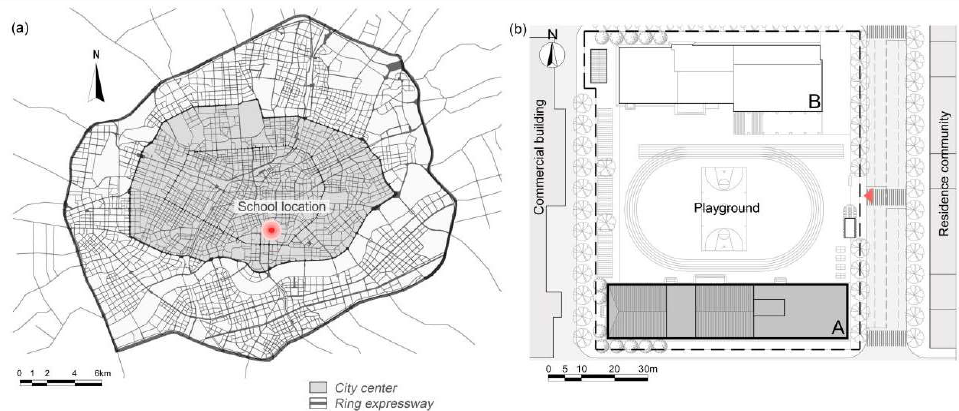
Figure 2. Location of selected primary school in Shenyang City ( a ), Site map ( b ). 114